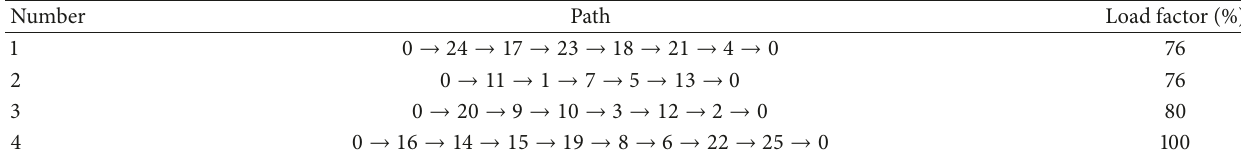
Table 3: Paths and load